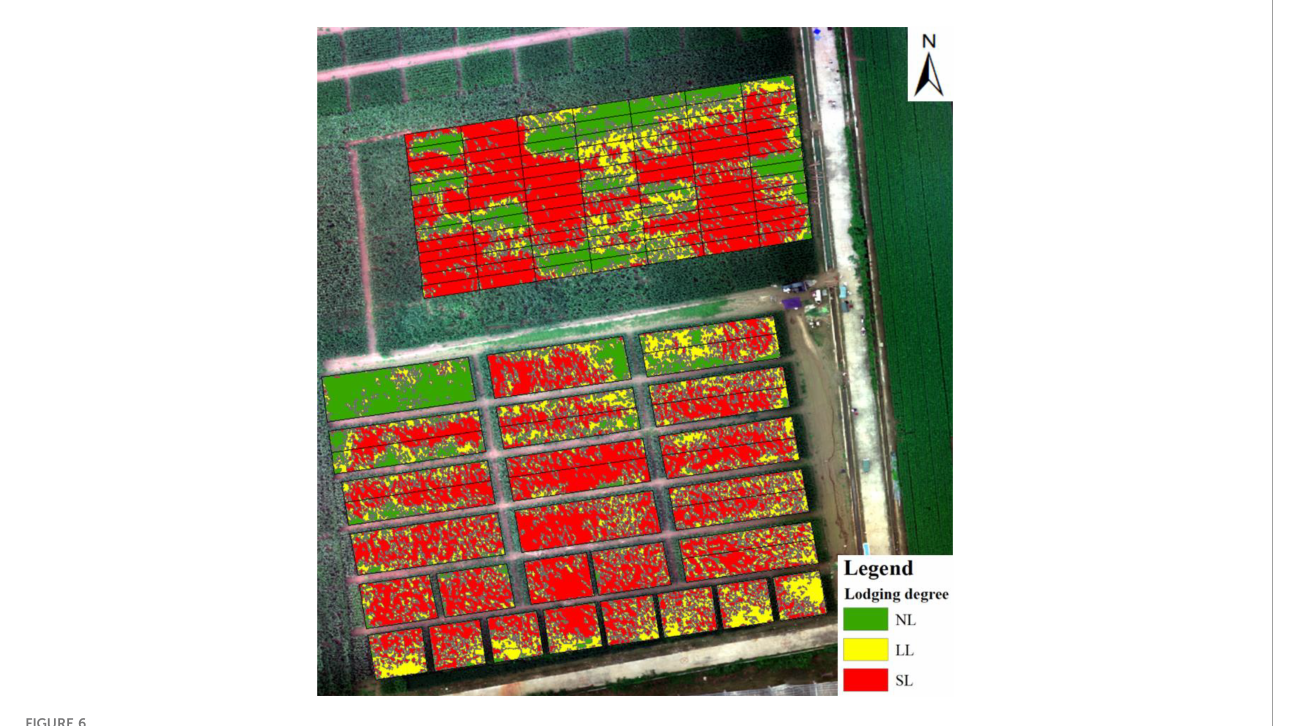
FIGURE 6 Distribution of pixel-level degree of maize